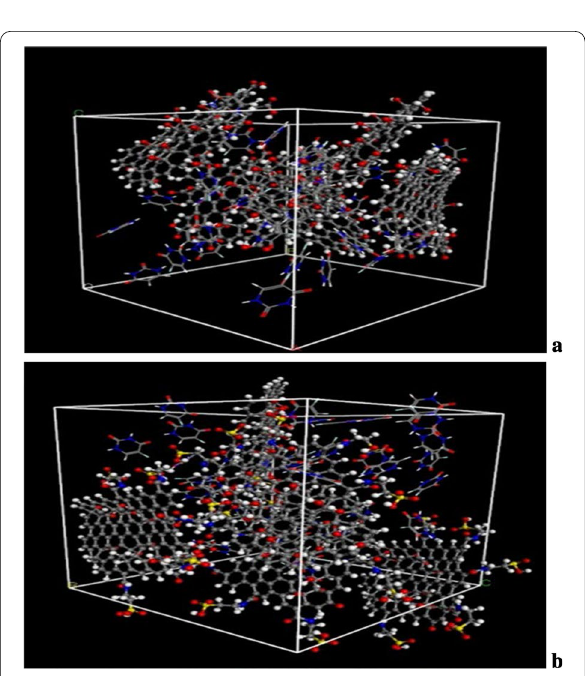
Fig. 15 Snapshots of the GO and 5-FU at the end of the MD ( a ). Snapshots of the Tau-GO and 5-FU at the end of the MD ( b